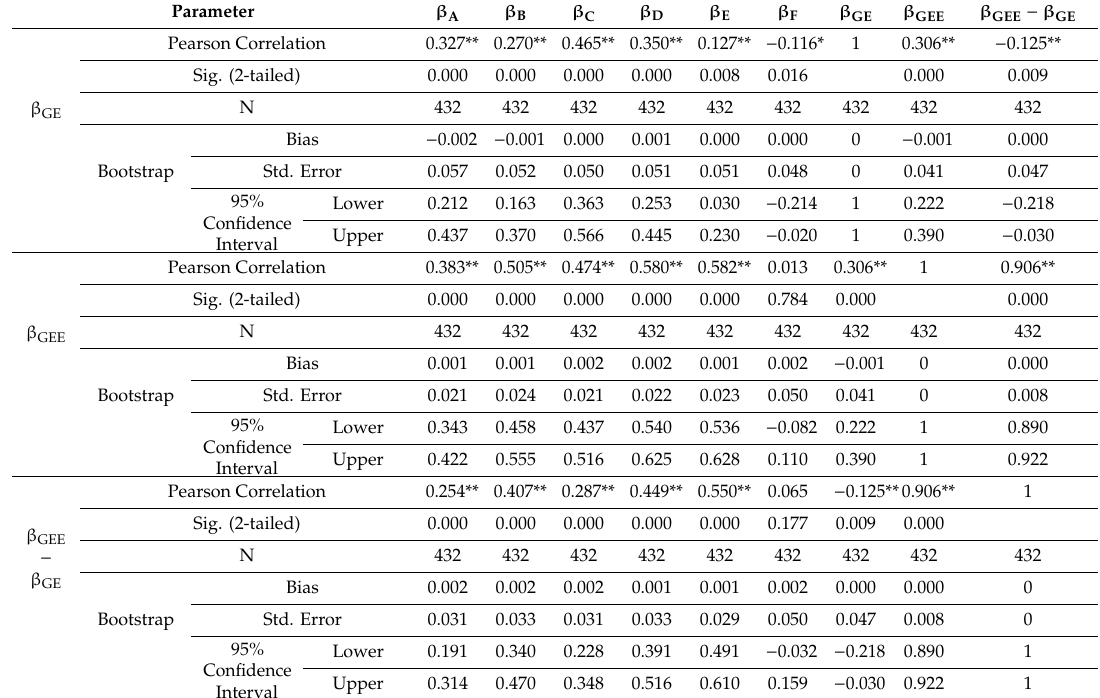
Table 7. Correlation analysis of the game elements existence beliefs and the game existence belief. Parameter